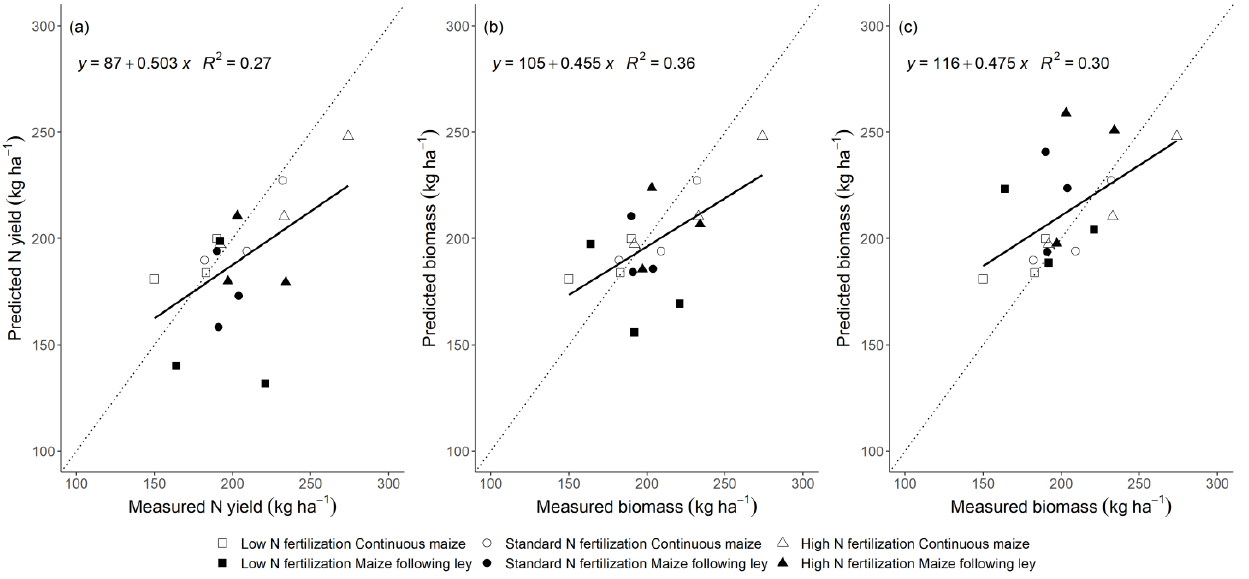
Figure 4. Measured and APSIM predicted maize nitrogen (N) yield of maize for experimental site 2, for the low, standard, and high N fertilization levels. Results are shown for the generic approach accounting for aboveground residues ( a ), above- and belowground residues ( b ), and the simple mineralization model ( c ) (see Figure 1). Table 6. Performance statistics of maize nitrogen yield (n = 6) for experimental site 3; R 2 =